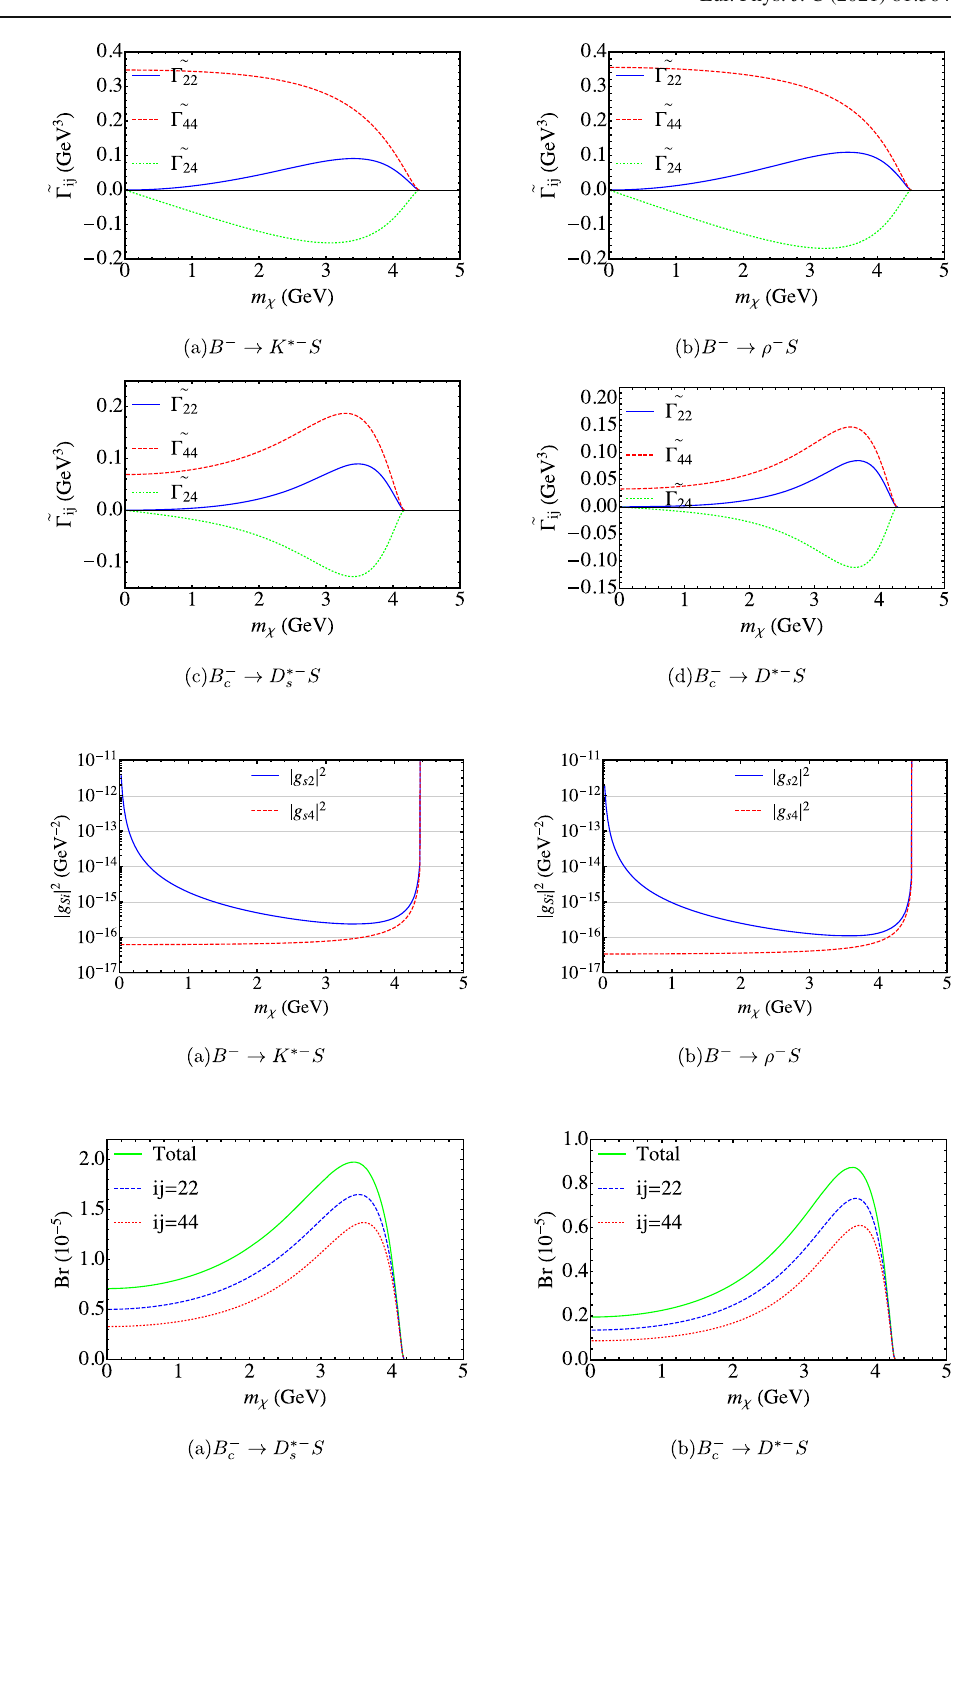
Fig. 7 Branching ratios of B c meson 0 − → 1 − decays with invisible